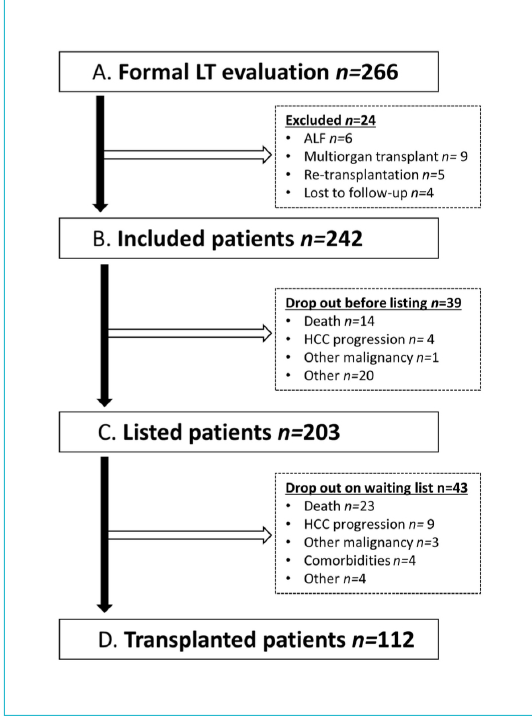
Figure 1: Patient flow chart. Illustration of a patient's medical course from initial assessment to liver transplantation. Reasons for exclusion and for drop-out preceding listing and liver transplanta- tion are detailed. liver transplantation, liver transplantation;